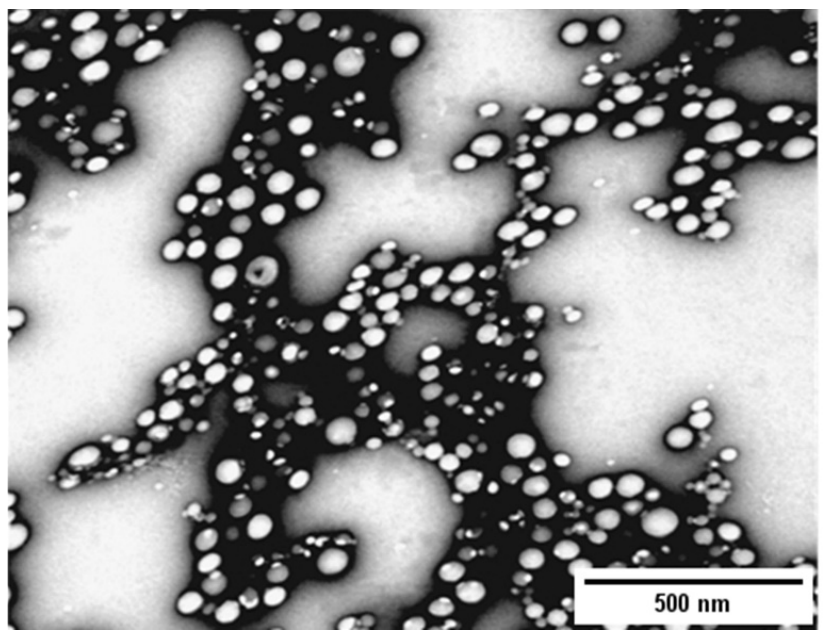
Figure 4. TEM image of KT-NPs.